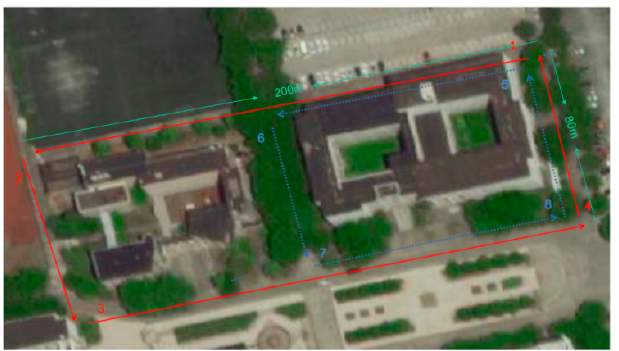
Figure 11. The 8-shaped path formed around Jingwen Library and Wenhui Building.